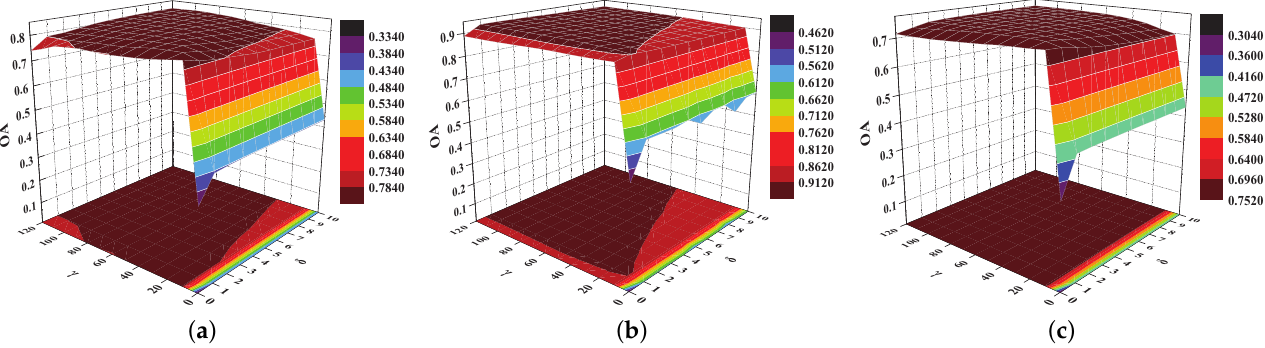
Figure 6. Classification results with different regularization parameters γ and δ . ( a ) PaviaU. ( b ) LongKou. ( c )